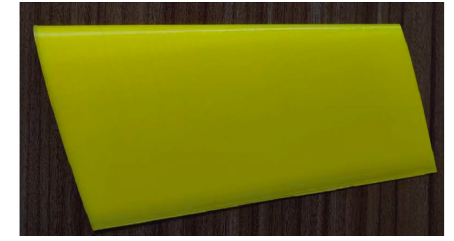
Figure 21: 3d printed airfoil.